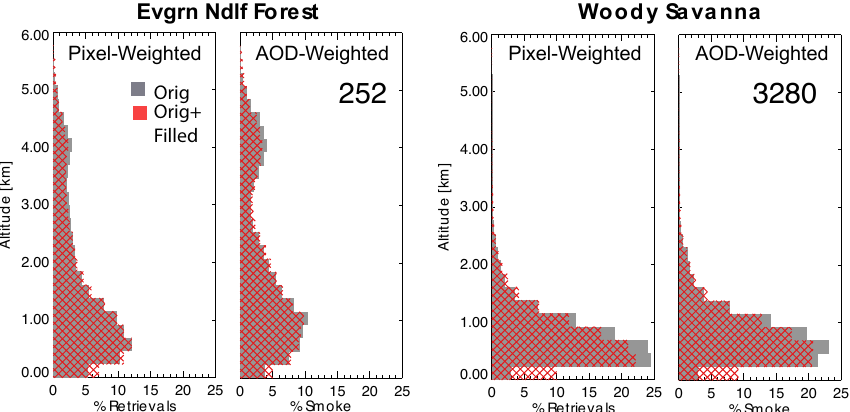
Figure 6. Vertical distribution of percentage of pixel-weighted and AOD-weighted stereo-height retrievals in 250-m bins for original retrievals (grey) and the missing height and AOD-filled retrievals (hatched red), over North American evergreen needle-leaf forest and African woody savannah. Numeric annotations indicate the number of plumes in each